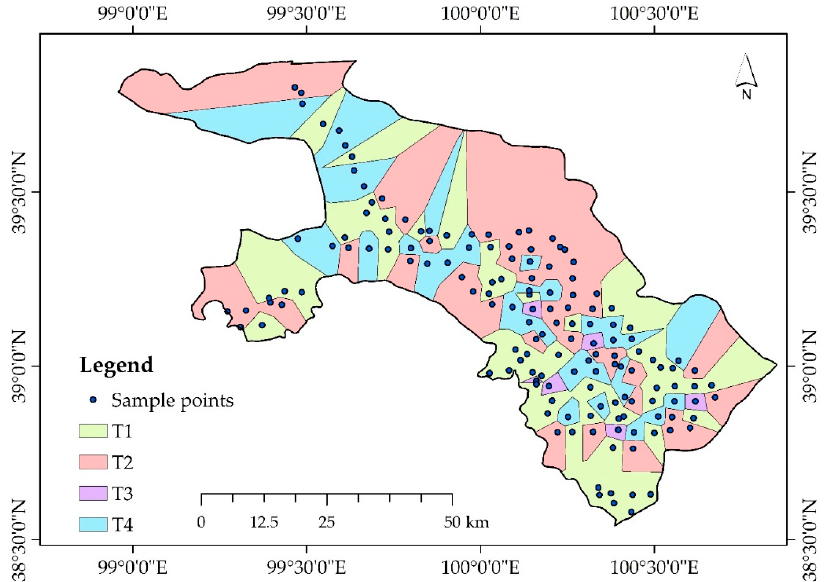
Figure 2. Distribution of the soil samples and soil types. Table 1. The soil types along the soil profile.